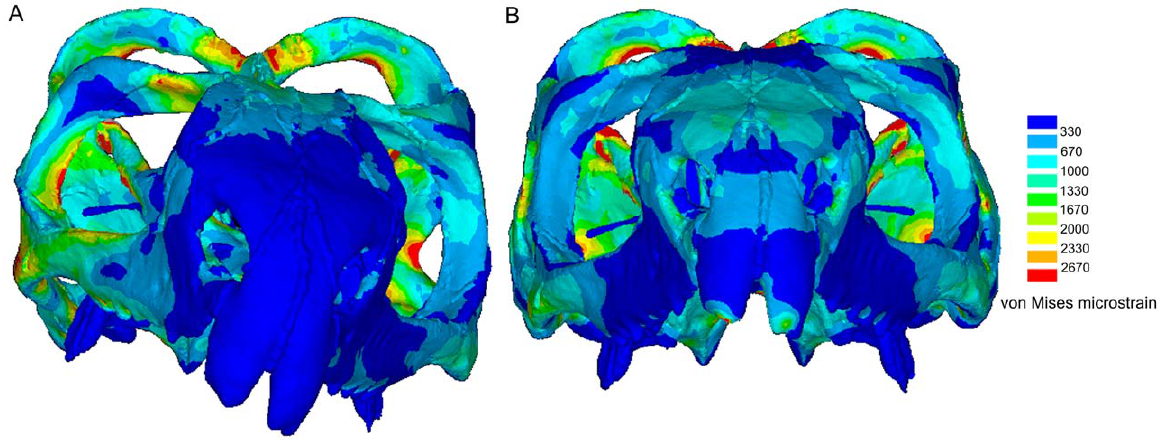
Figure 3. von Mises FEA plots during two single bites. Deformation and von Mises strain plots of the skull of Sphenodon during A. right unilateral biting and B. during bilateral biting on the anterior-most chisel-like teeth; (note the displacements are scaled by a factor of